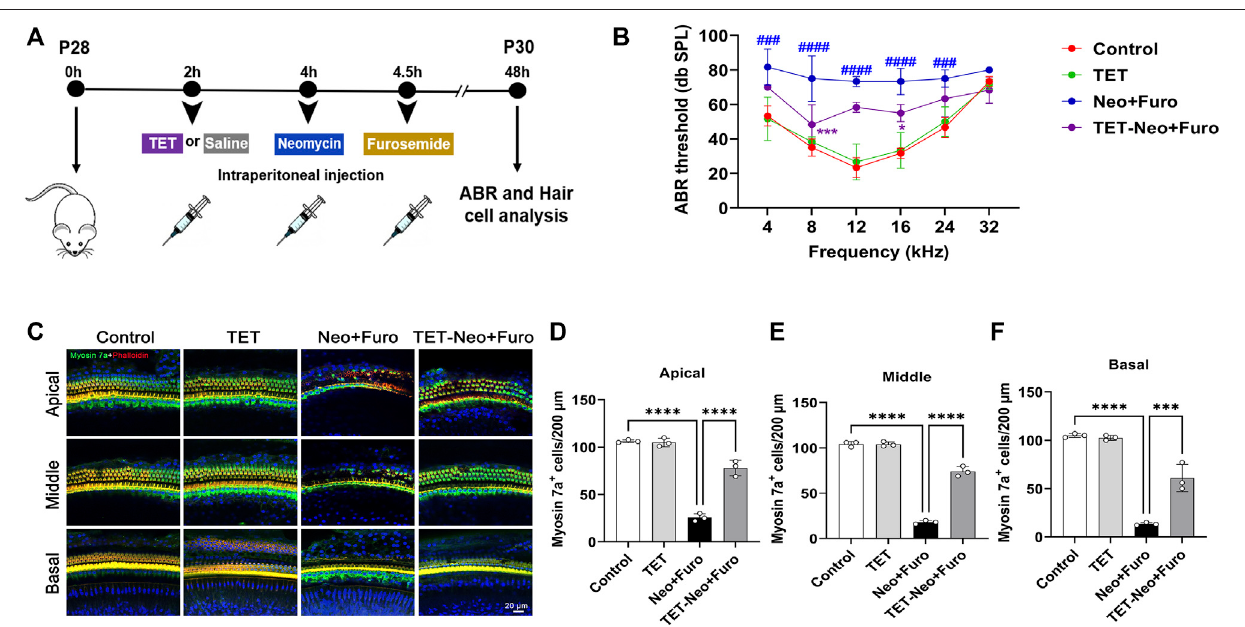
FIGURE2| TETimprovesauditoryfunctionandprotectsagainstneomycin-inducedcochlearhaircellloss (A) Schematicillustrationoftheacuteneomycindamage model (B) ABR thresholds were analyzed to determine the effect of TET on neomycin-induced hearing loss in mice (n = 6) (C) Immunostaining of cochlear hair cells marked by myosin 7a in the apical, middle and basal turns. Scale bars: 20 μ m (D-F) Quanti fi cation of the number of cochlear hair cells per 200 μ m in apical, middle and basal turns (n = 3). * p < 0.05, *** p < 0.001, **** p < 0.0001.